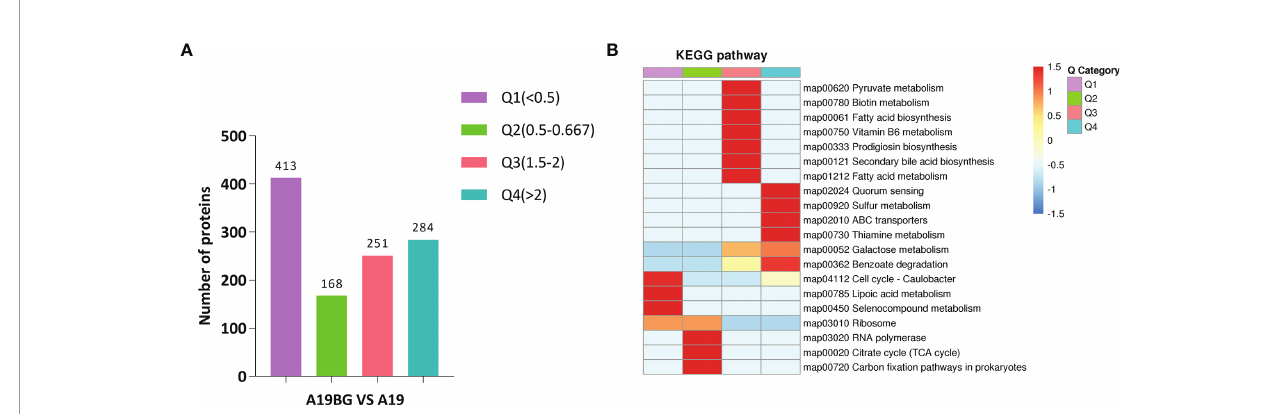
FIGURE 3 | Cluster analysis of KEGG pathways. (A) Number of proteins with different differential expression multiples. (B) KEGG cluster analysis of the Q1-Q4 subgroups. According to the differential expression multiple, the DEPs were divided into four groups, called Q1 to Q4. The functions of interest in the different groups were clustered together using hierarchical clustering based on Fisher ’ s exact test p-values obtained from the enrichment analysis and plotted as a heatmap. the horizontal side of the heatmap represents the results of the enrichment test for the different groups and the vertical side is a description of the differentially expressed enrichment-related functions are depicted. The colour blocks corresponding to the descriptions of differentially expressed proteins and functions in different groups indicate the degree of enrichment. Red indicates strong enrichment, and blue indicates weak